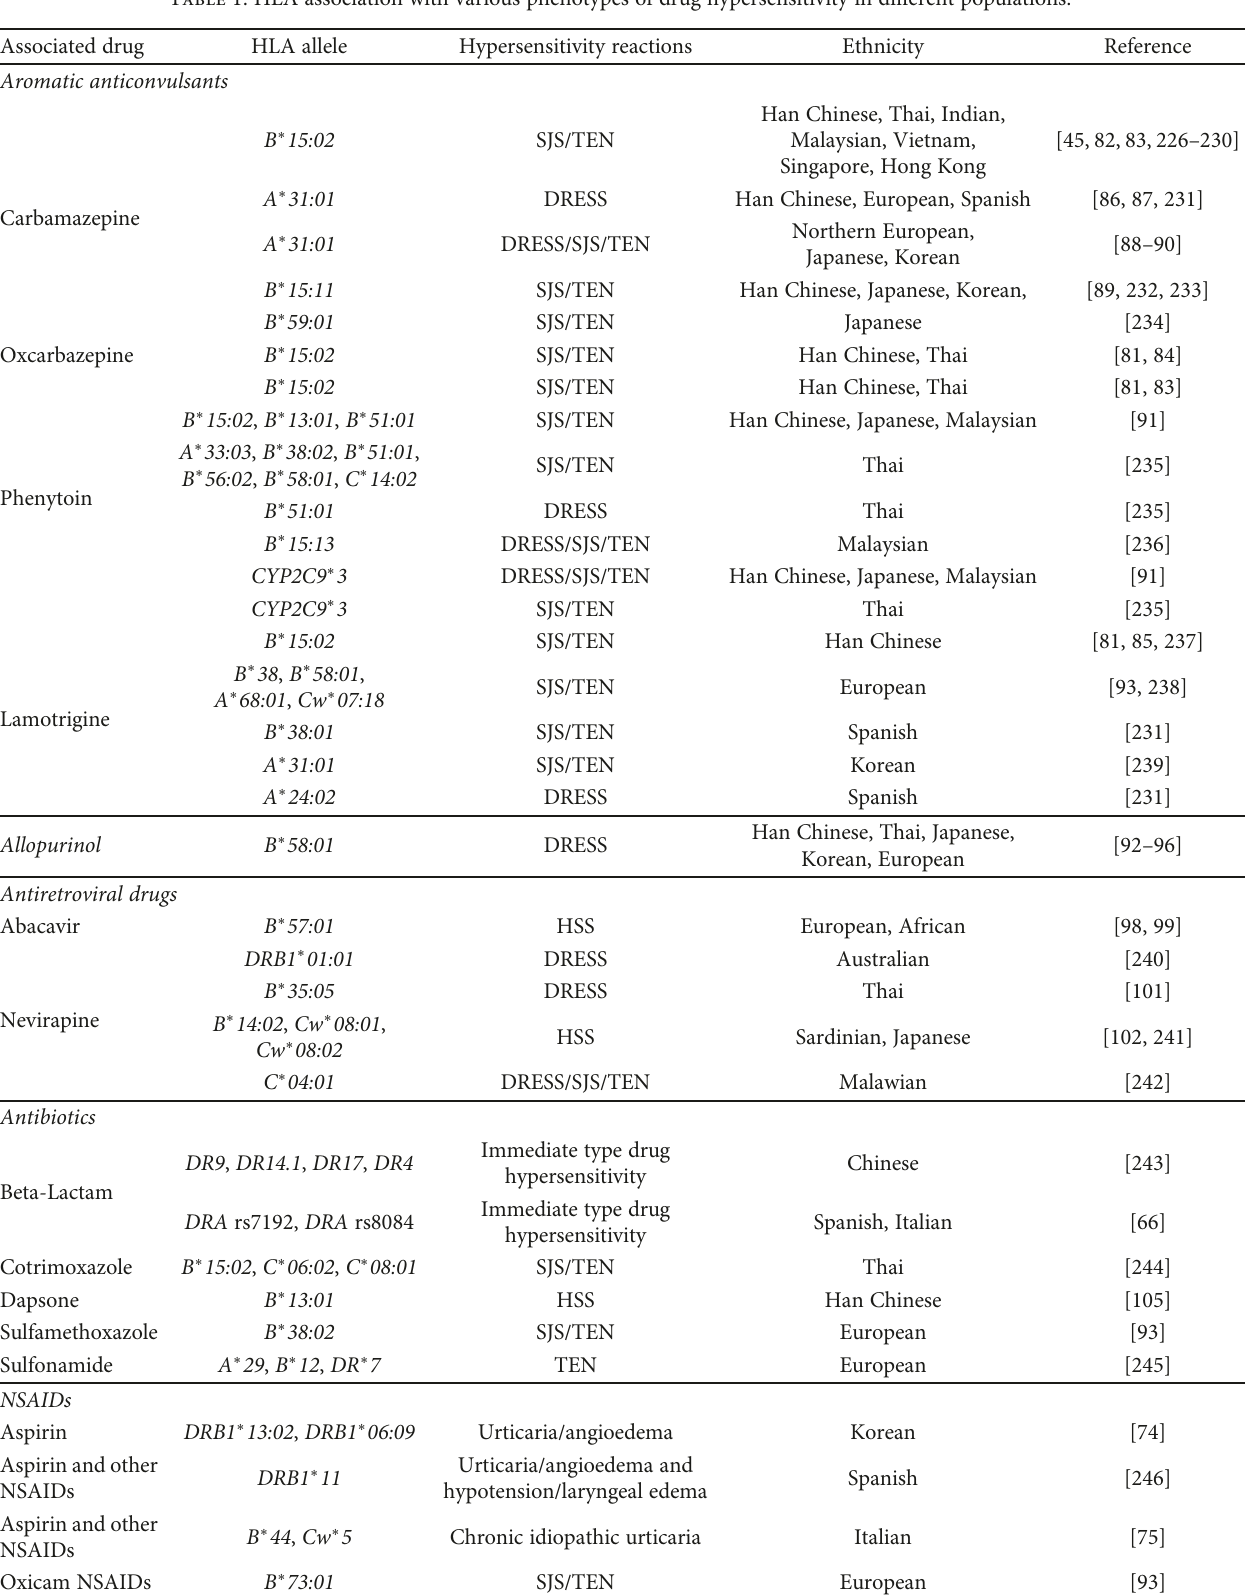
Table 1: HLA association with various phenotypes of drug hypersensitivity in di ff erent populations. Associated